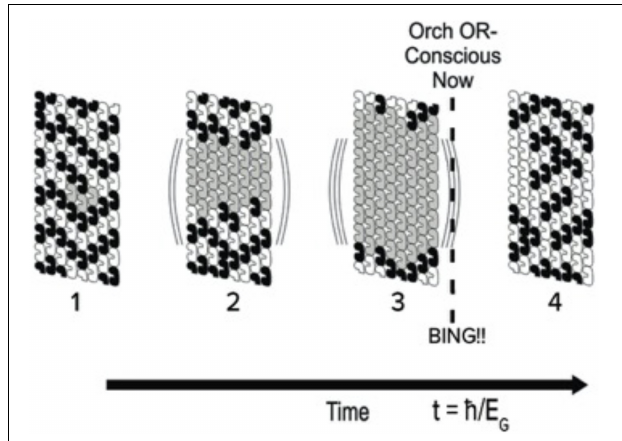
FIGURE 8 | Portion of microtubule lattice in which tubulins within helical pathways may be in one of 2 classical states (black or white) with growing number of superposition states (gray). One portion of one microtubule is shown, but many microtubules may be involved in brain neurons by entanglement. At time t = è /E G , threshold is met and an Orch OR conscious moment (NOW) occurs, BING denotes phenomenal experience, or qualia.